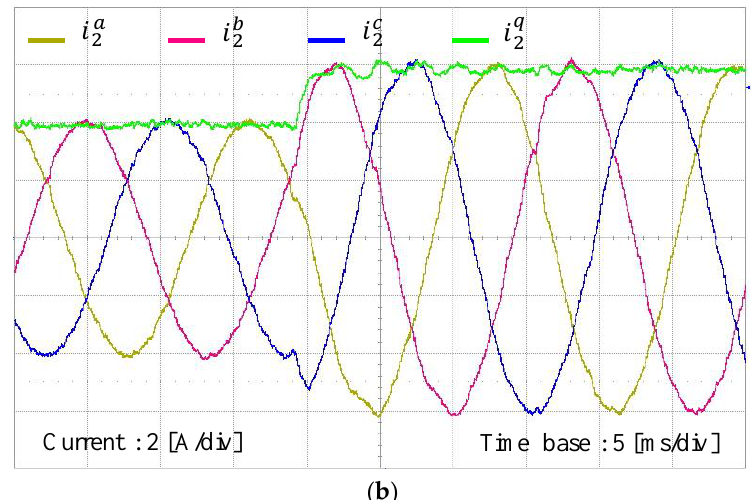
Figure 15. Experimental results for the proposed control scheme under step change in q -axis current reference. ( a ) Grid-side current responses at the SRF; ( b ) three-phase grid-side current responses.